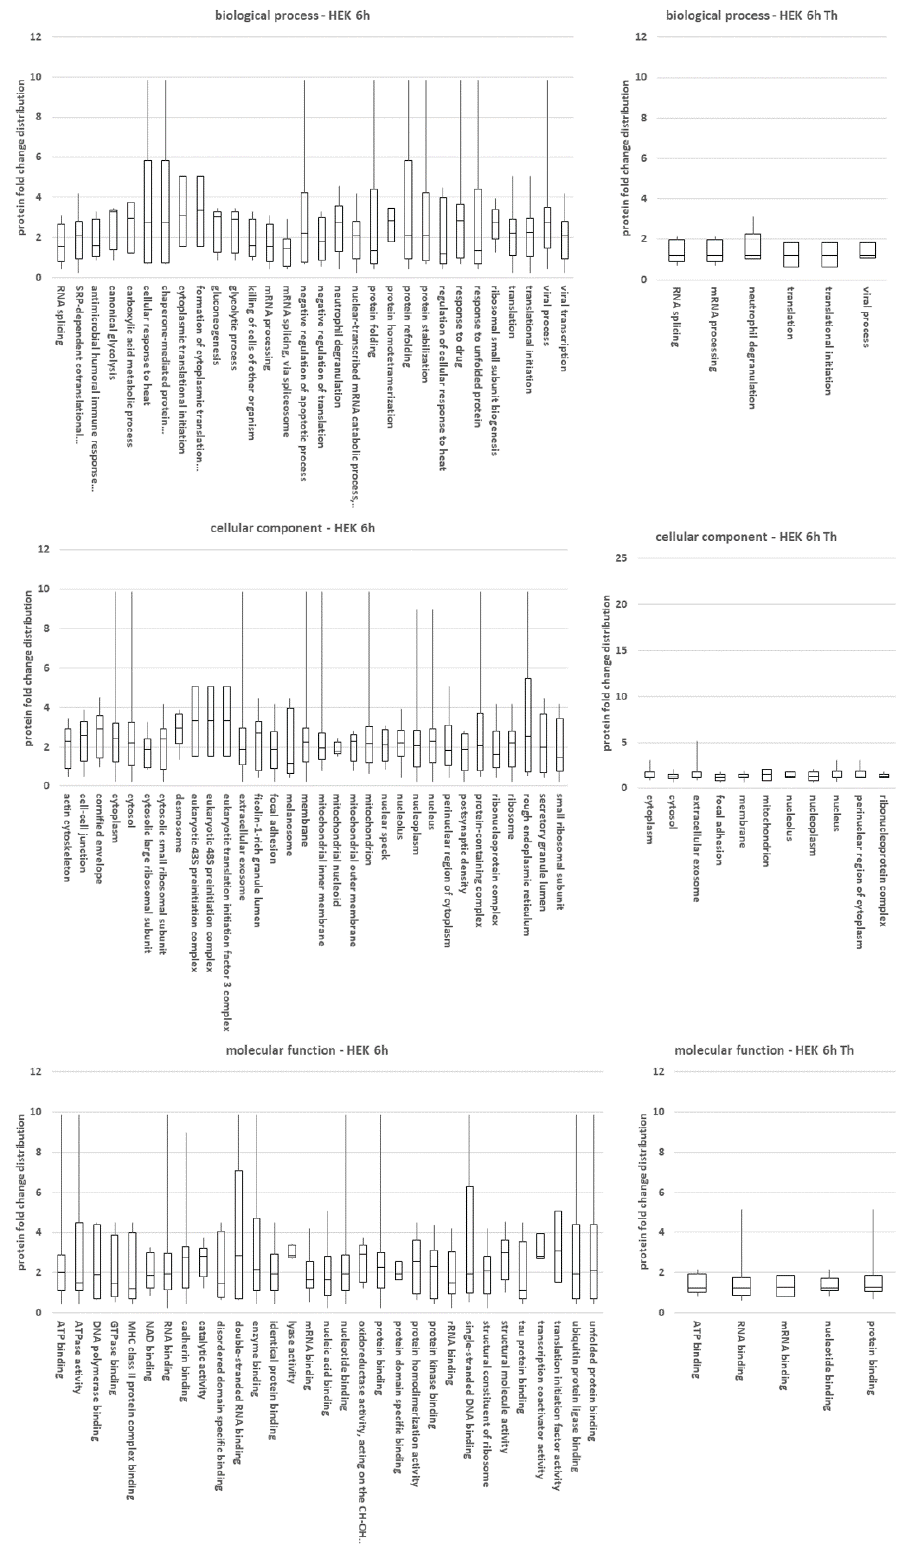
Figure 4. Overrepresentation analysis of protein hits using genecodis. The eIF3A-dependent biotinylation ratios for the proteins are presented as box plots for HEK-293T cells at the 6 h labeling time point. Data for eIF3A were omitted as the high score for this protein biased box plots containing eIF3A. Box plots for HCT-116 and other time points can be found in the Figure S4.